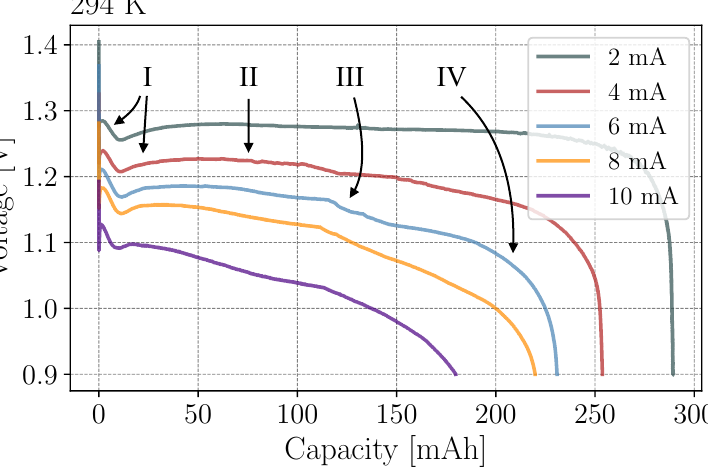
Figure 6. ZAB PR48 discharge profiles at 294 K and various constant discharge currents from 2 mA to 10 mA. The annotations I–IV represent different operating phases of the cell.